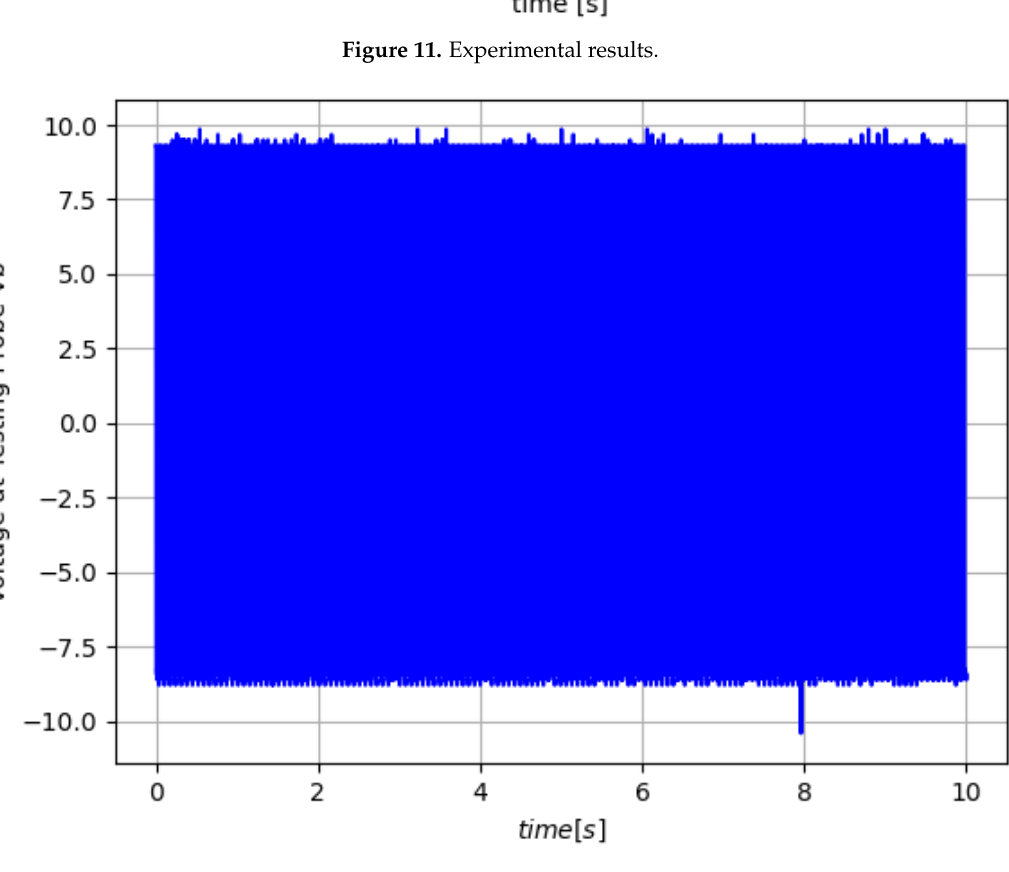
Figure 12. Experimental